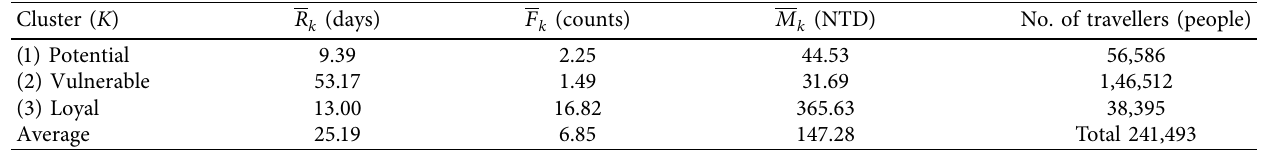
Table 14: Clustering results by K -means for 2019 Q 2.